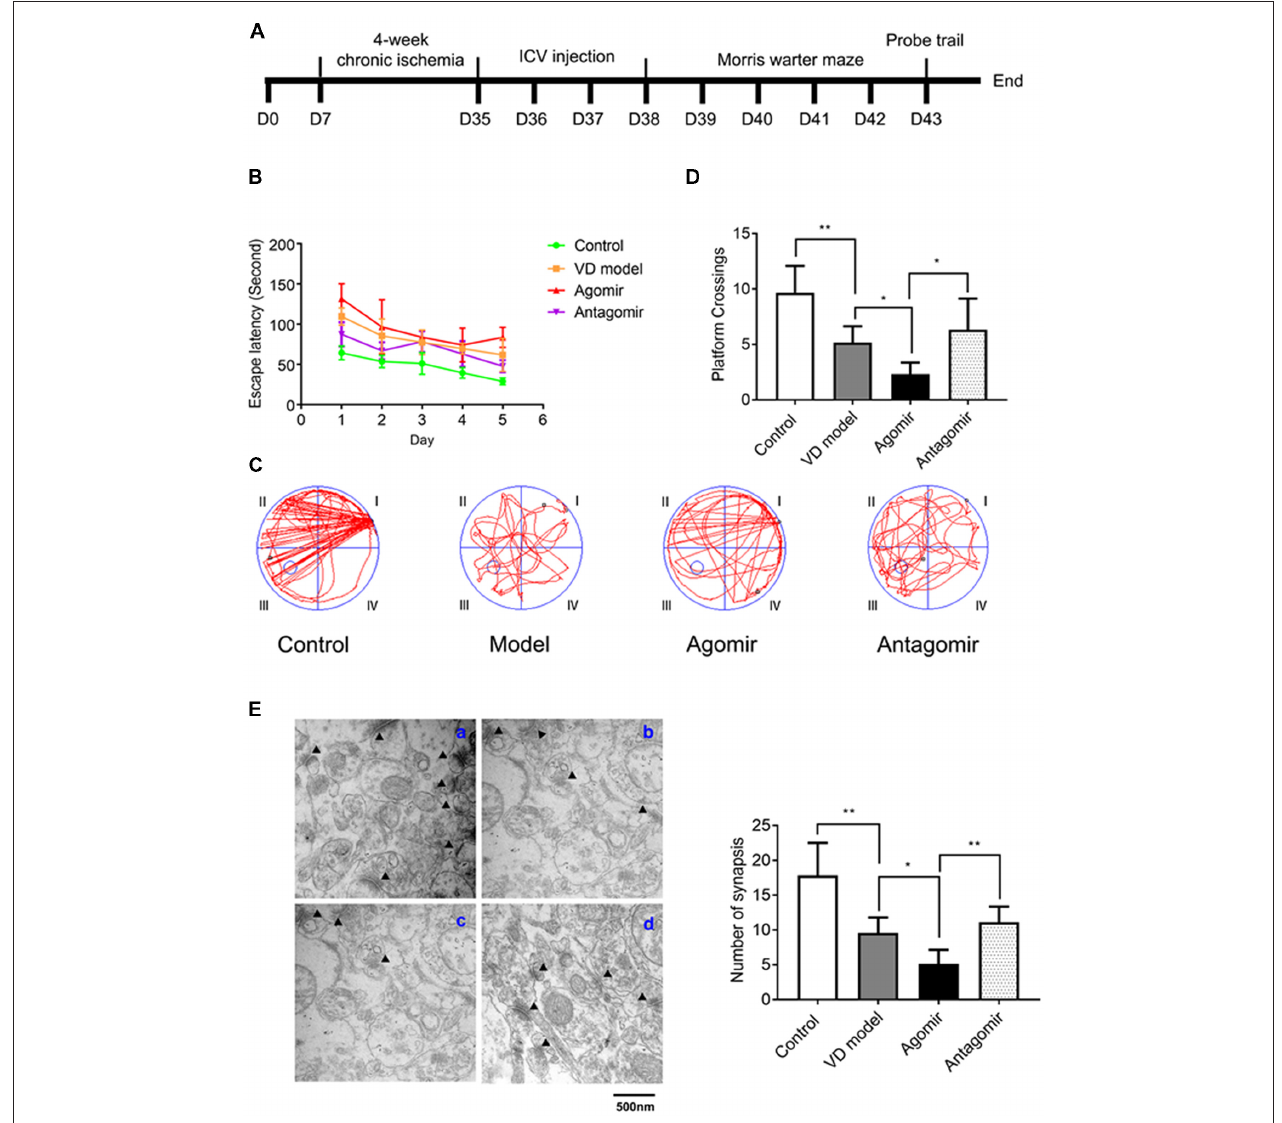
FIGURE 4 | Intracerebroventricular (ICV) injection of miRNA-210-5p agomir aggregates cognitive impairment level and antagomir attenuates cognitive impairment in VD model ( n = 13/group). (A) Timeline. (B–D) The latency, the moving trails of rats in platform crossing test and number of rats crossing over the platform. (E) Synapses were indicated with black triangles; a: Control group, b: Model group, c: Agomir group, d: Antagomir group; bar chart showed the number of synapses ( n = 6/group). Data are shown as mean ± SD values, and statistical significance between both groups is defined as ∗ p < 0.05; ∗∗ p <